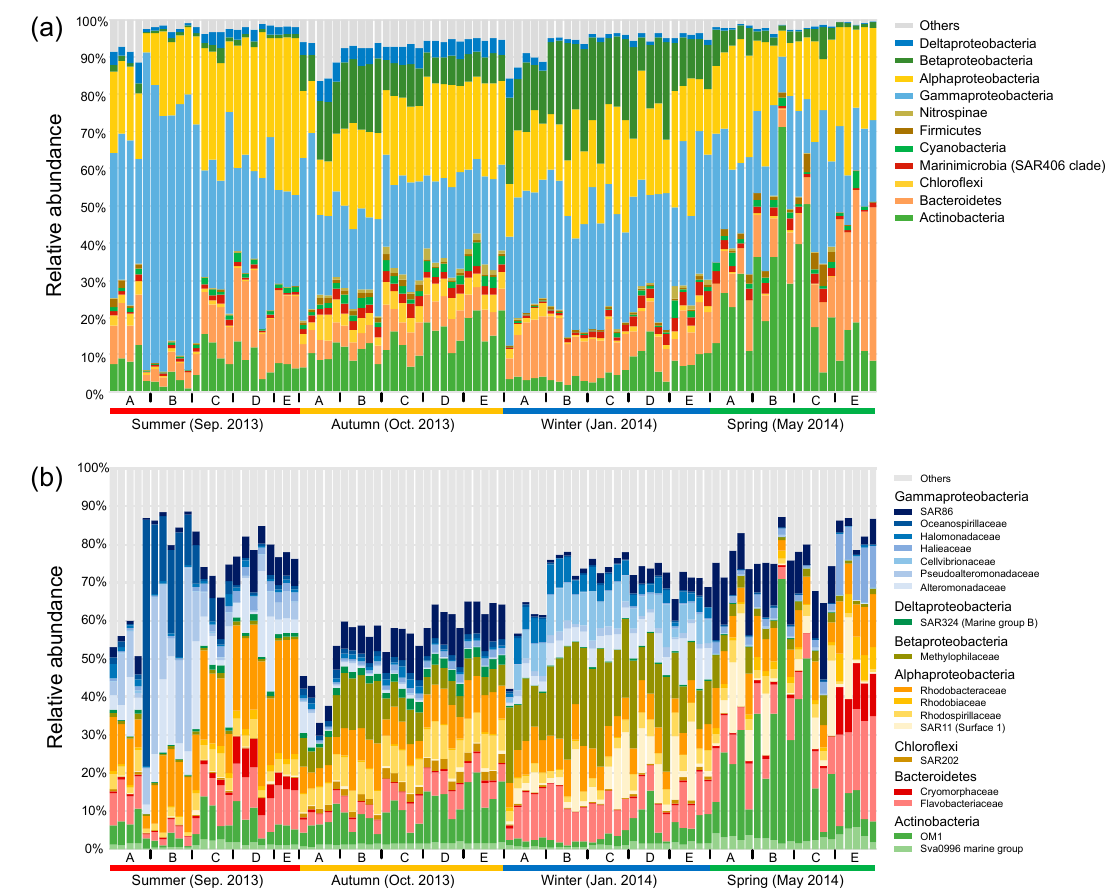
Figure 2. Relative abundance of dominant bacterial phyla and proteobacterial classes (average relative abundance > 1% at least in one season) ( a ) and families (average relative abundance > 2% at least in one season) ( b ).